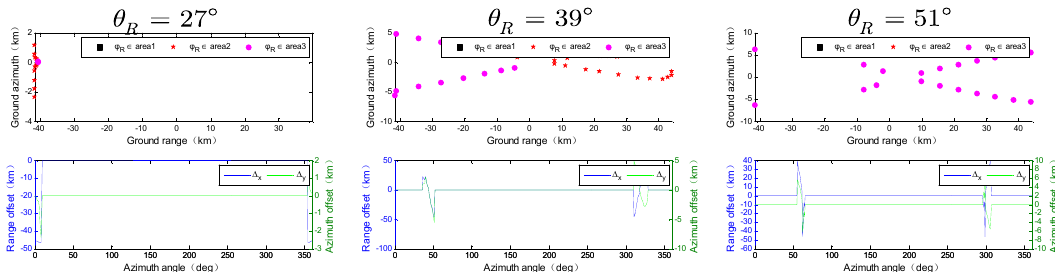
Figure 10. The location diagram of platforms.